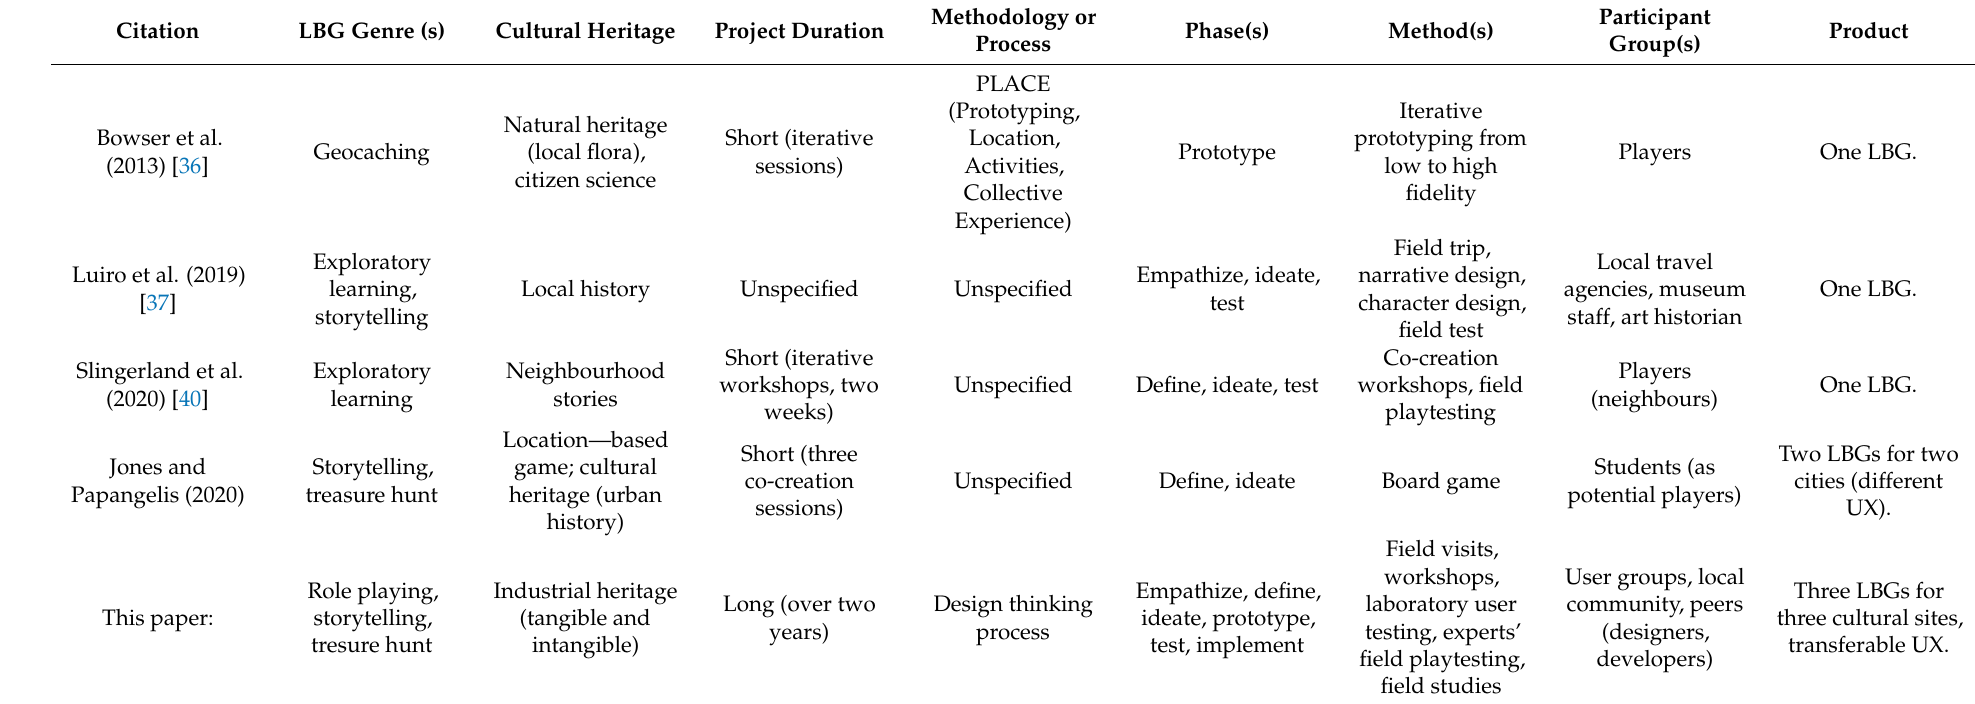
Table 1. Summary of co-design and participatory design approaches for location-based games for cultural